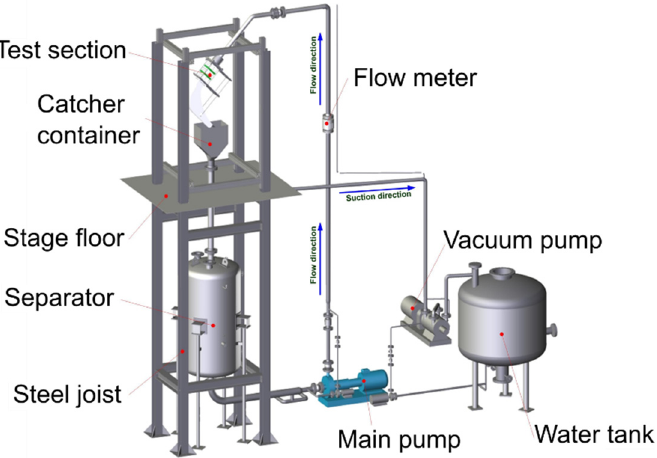
Figure 3. Scheme of the FIDES test facility.